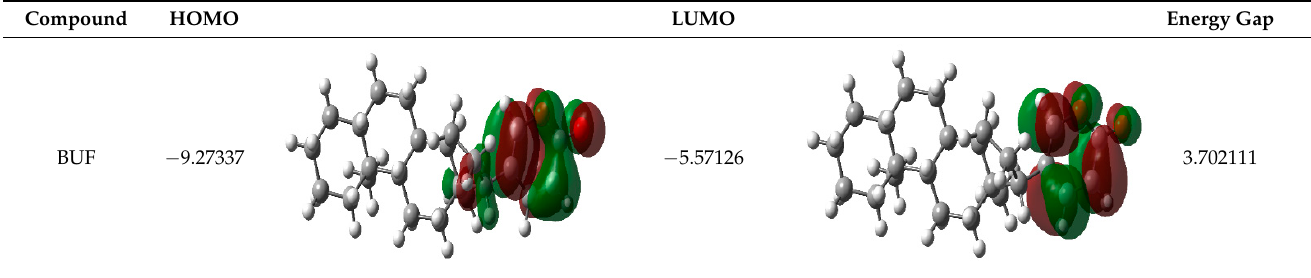
Table 7. EHOMO and ELUMO and ∆ E values of selected top binding scored bioactive molecules and standard PDE 5 inhibitor.